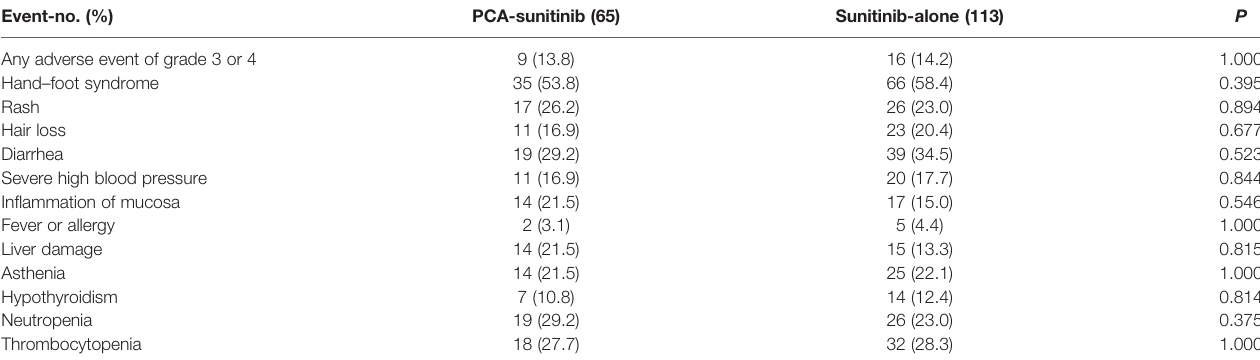
TABLE 3 | Summary of severe adverse events in sunitinib-treated patients. Event-no.